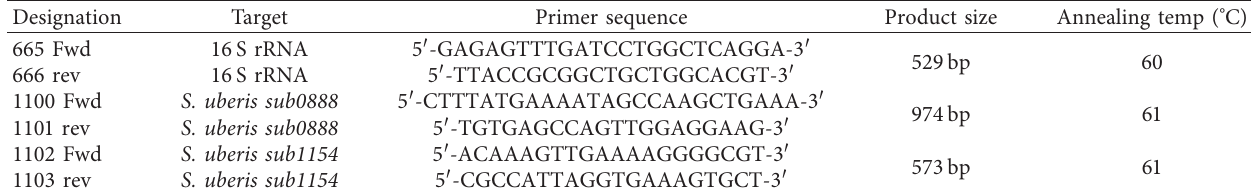
Table 1: Oligonucleotide primer sequences used in this study.